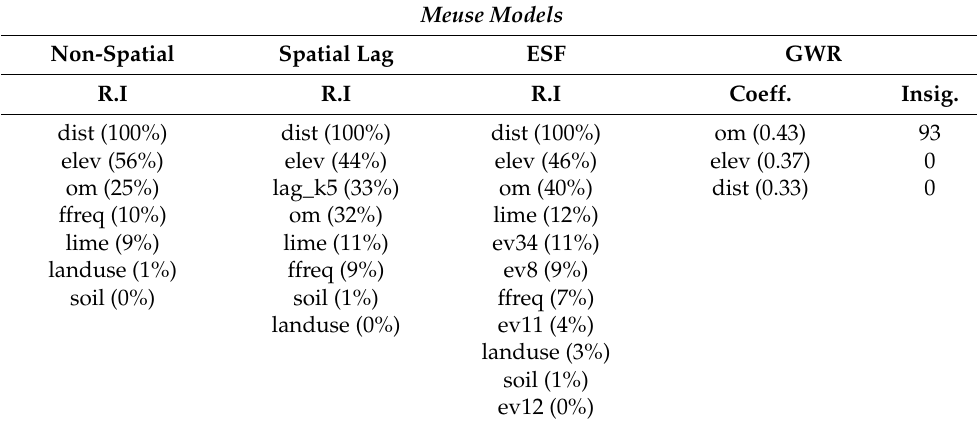
Table 4. Impact of the explanatory variables on the models. For each model, the variables are ordered and enlisted based on their impact (e.g., the highest relative importance is at the top and the lowest at the bottom). R.I = relative importance, Coeff. = mean absolute value of the standardized estimated parameters, Insig. = number of insignificant parameters